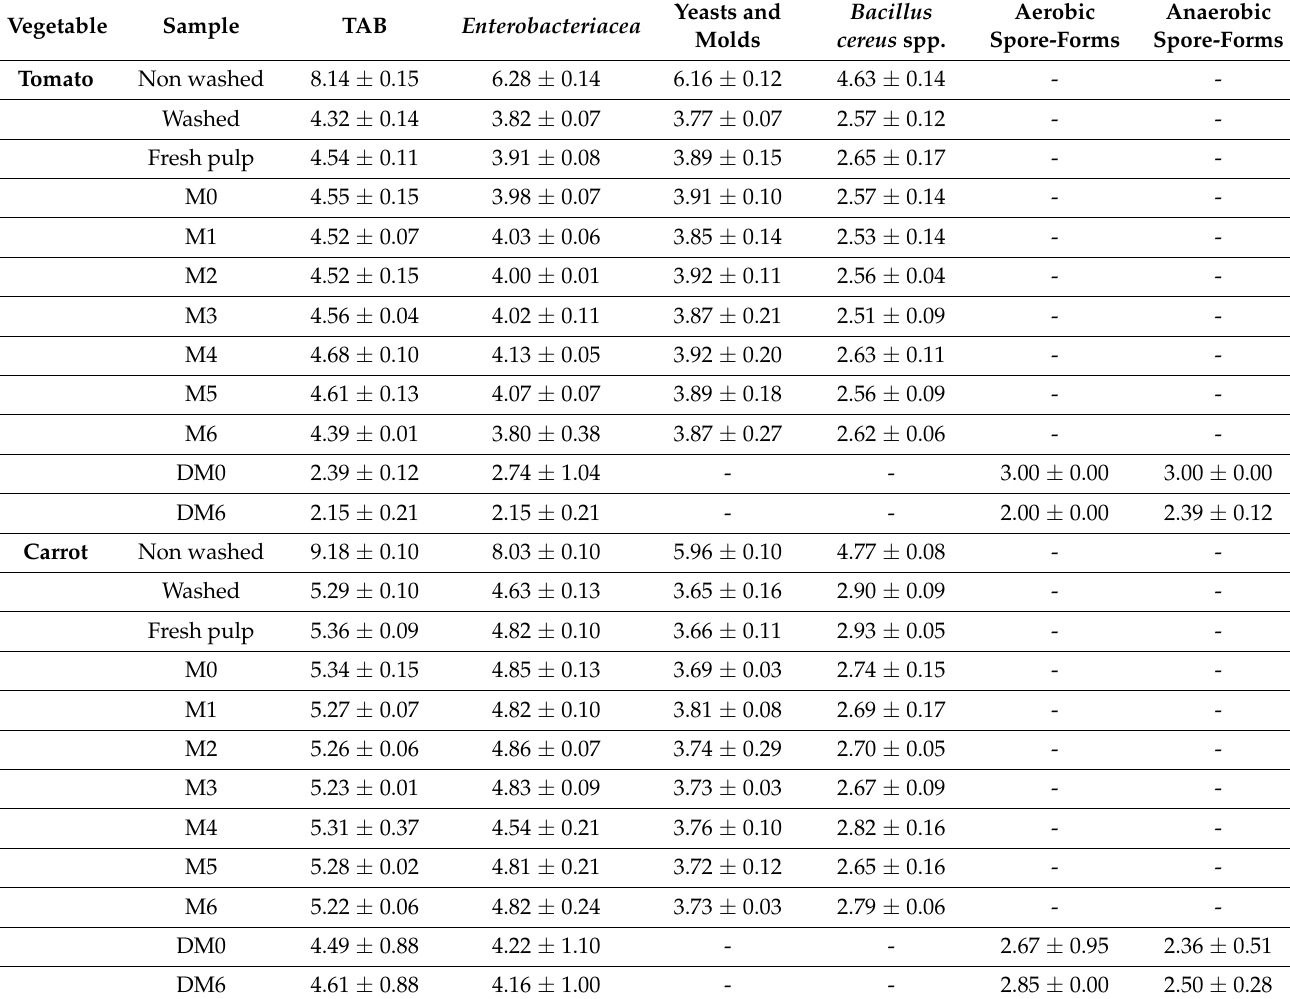
Table 1. Microbial counts ( n = 2) present in cherry tomato and baby carrot by-products before and after the washing process, as well as during the 6 months of pulps freezing and drying storage. All microbial count results (mean ± standard deviation) were expressed in log(CFU g − 1